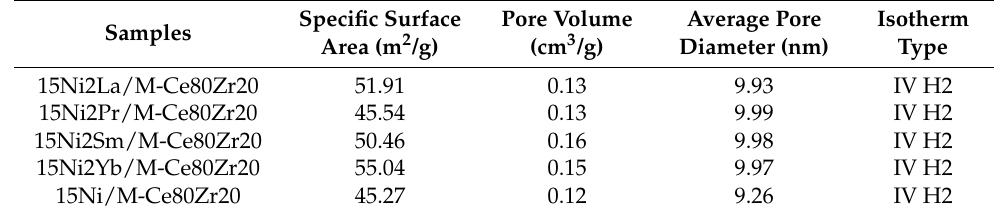
Table 1. Structural properties of the catalysts based on the N 2